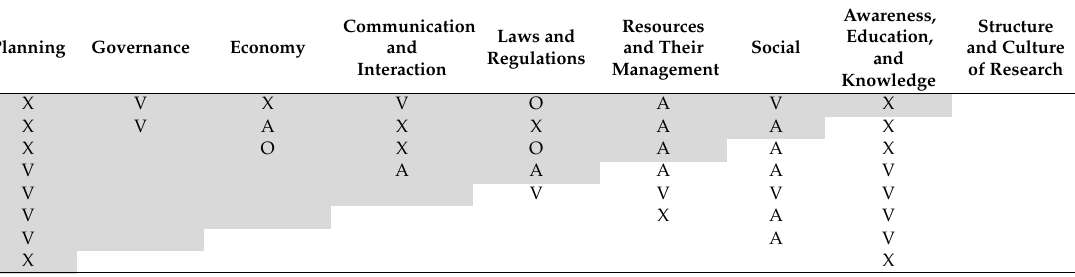
Table 6. Structural self-interaction matrix